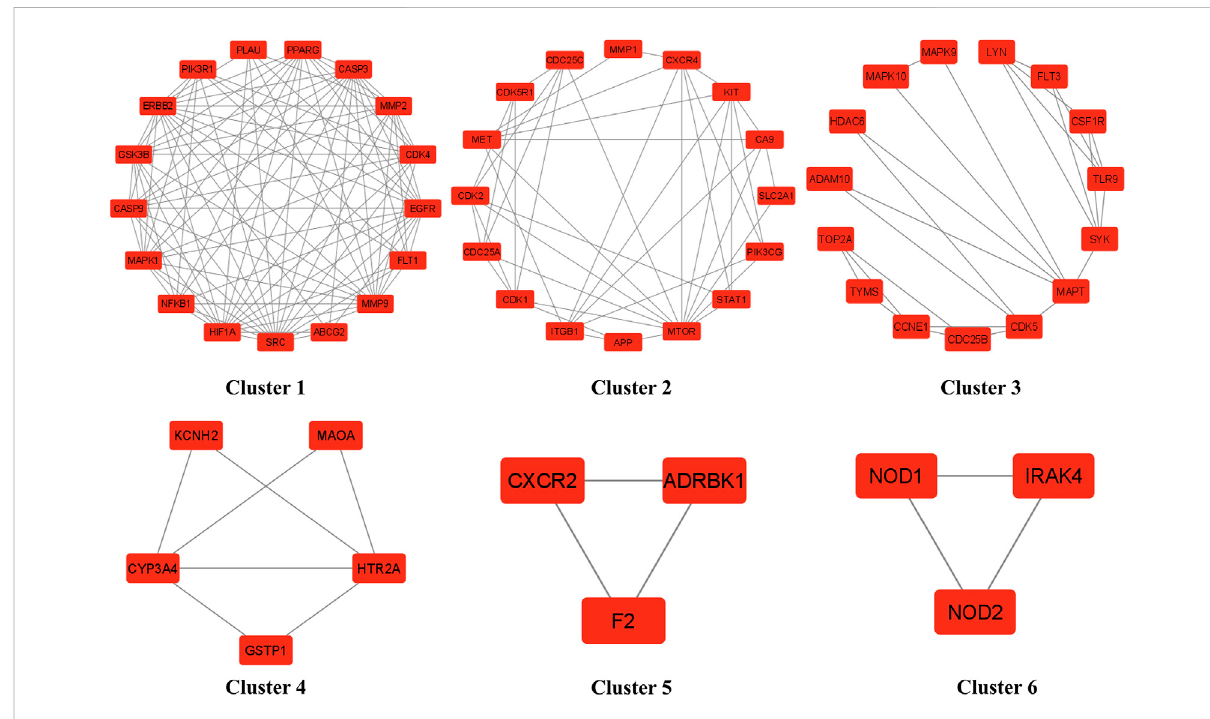
FIGURE 5 Six clusters of PPI network (PPI = Protein-protein